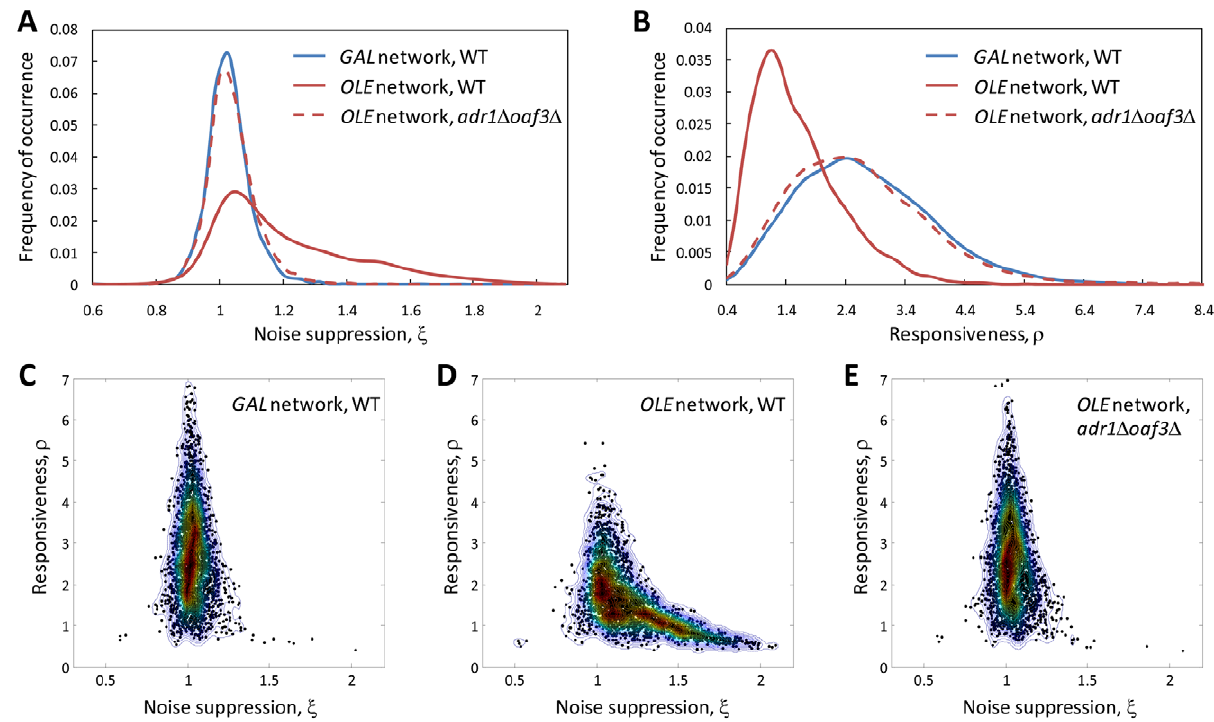
Figure 2. Feed-forward loops of the OLE network endow the system with ability to filter high-frequency fluctuations of the stimulus whereas feedback loops of the GAL network confer responsiveness to the environmental changes. (A, B) Distribution of the noise suppression and responsiveness statistics for GAL (WT) and OLE (WT or adr1 D oaf3 D ) networks, respectively. (C–E) Responsiveness/noise suppression plots for GAL (WT) and OLE (WT, adr1 D oaf3 D ) networks, respectively. The j and r were calculated based on 3000 random time-varying stimuli and system responses (see also Figures S3, S4, S5, S6 and S7). The contour plots were constructed using a bivariate Gaussian kernel density estimator (see Text S1). Noise suppression values less than 1 indicate the system responses to these stimuli contain higher harmonics than the input signals and vice versa . Low responsiveness values indicate poorly matched input and output signals. D denotes lack of a corresponding gene.